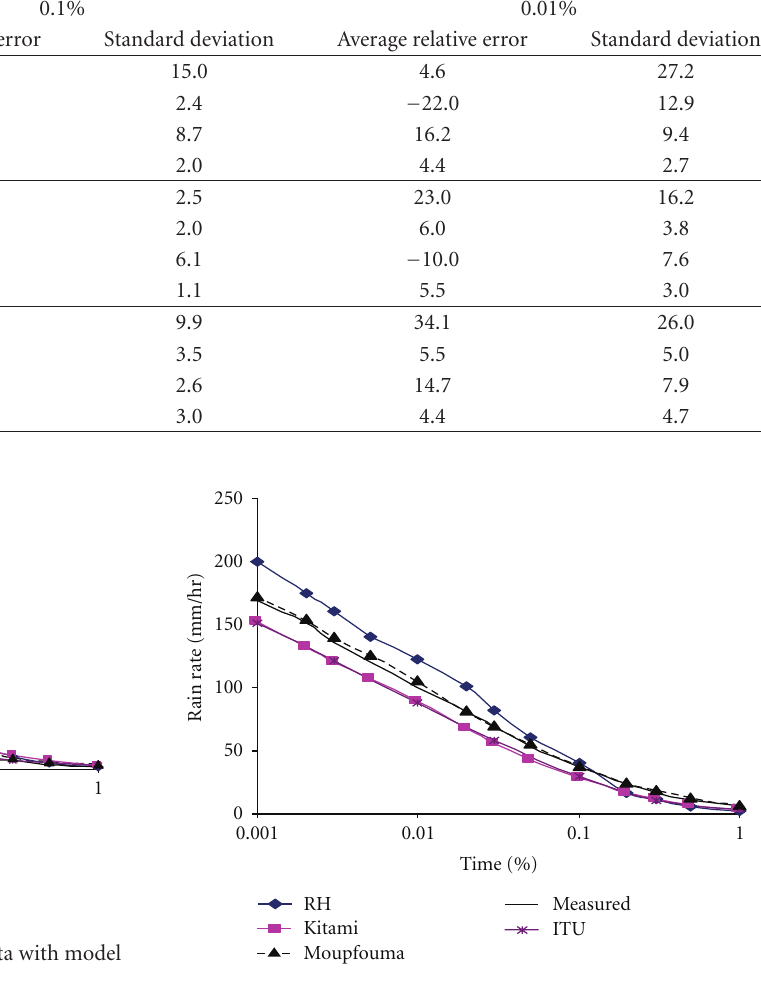
Figure 3: Comparison of measured UNILAG rainfall data with model predictions.